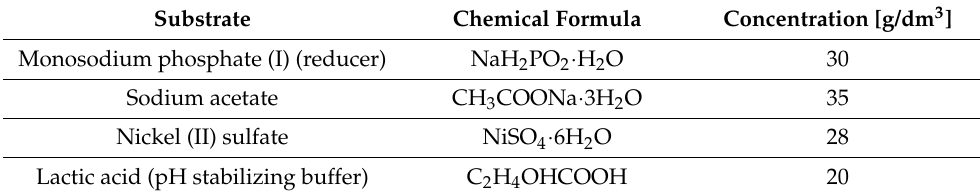
Table 3. Components concentrations of nickel deposition